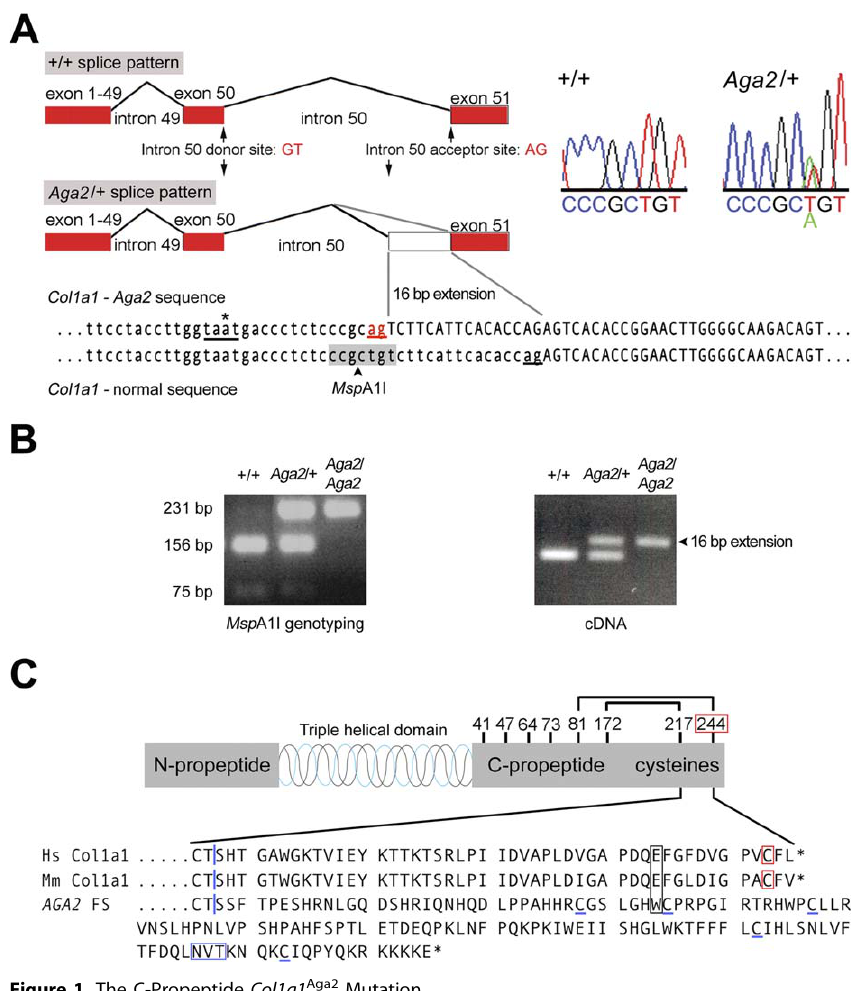
Figure 1. The C-Propeptide Col1a1 Aga2 Mutation (A) Mutation scheme. In Aga2 , splicing occurs at the new splice acceptor site (ag, highlighted red). The taat domain (underlined) harbors a putative spliceosome branch site (*). (B) Genotyping and presence of the extended transcript. (C) Alignment of human and murine Col1a1 terminal C-propeptides and prediction of the Aga2 frameshifted sequence. The start of mouse exon 51 (52 in human) is marked by a blue line. The frameshifted cysteine (C244) is boxed in red, newly introduced cysteines are underlined in blue; the potential N - linked oligosaccharide ( CHO ) attachment site is boxed in blue. Start of the human frameshift mutation described by Willing et al. [30] is boxed in